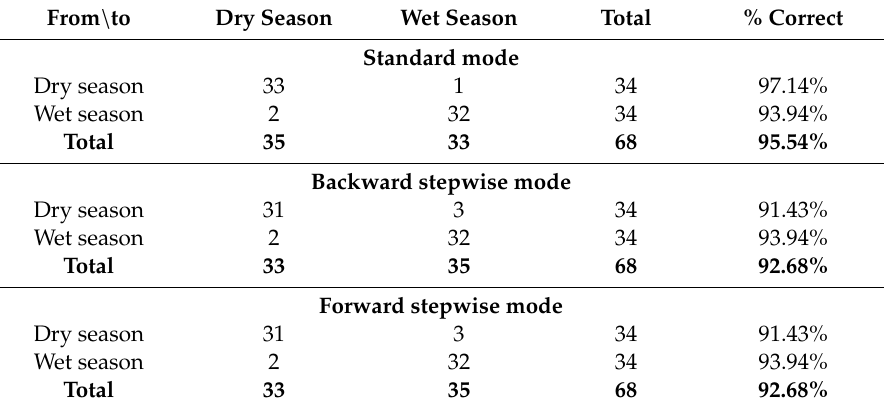
Table A1. Classification matrix for DA of seasonal change.